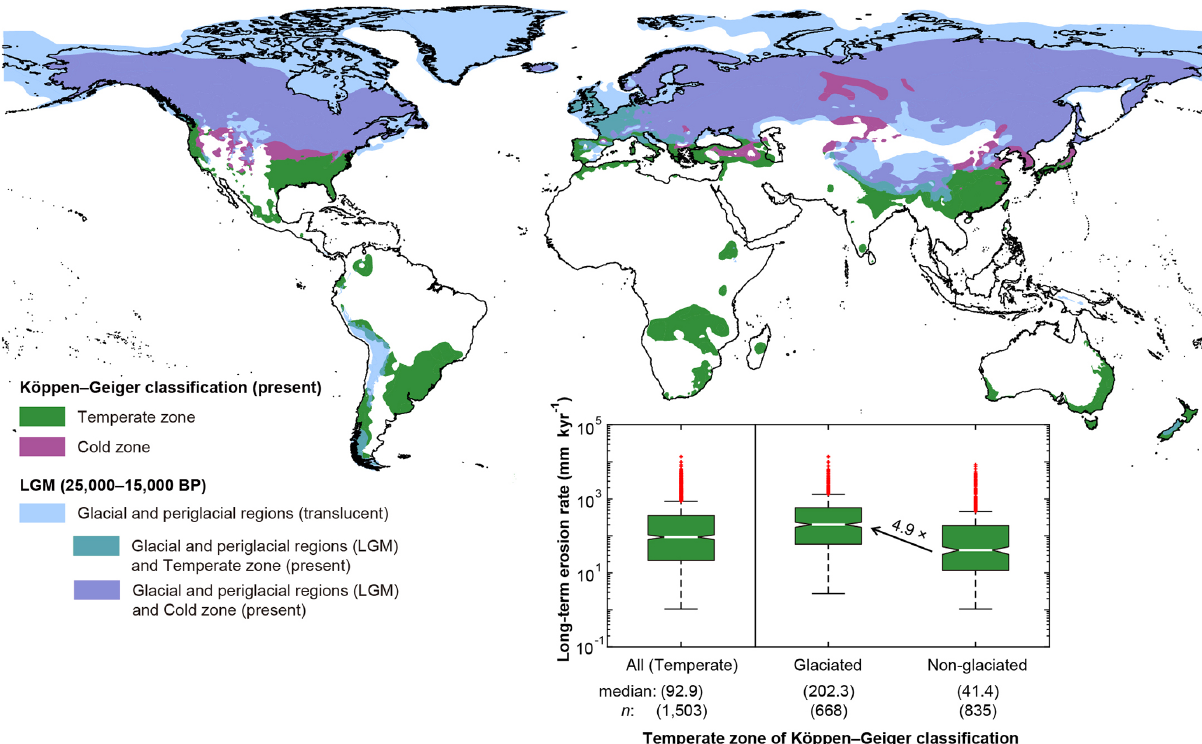
Figure 6. The extent of glacial and periglacial regions at the last glacial maximum (LGM) and the area of the Temperate and Cold zones of the Köppen–Geiger climate classification in the present. The glacial and periglacial regions were drawn from Ray and Adams (2001), according to the description in Sect. 3. The inset panel compares long-term erosion rates in the Temperate K–G zone with and without glacial influences at the LGM, indicating 4.9 times higher median erosion rates in formerly glaciated regions compared to non-glaciated regions.